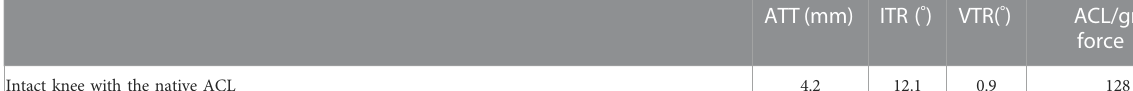
Intact knee with the native ACL